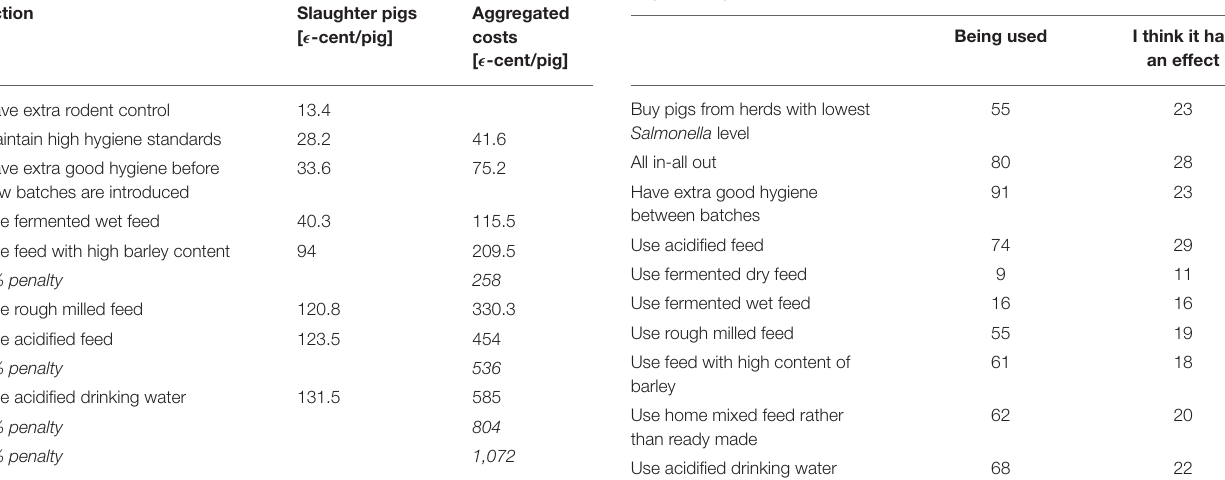
TABLE 6 | Share of farmers who use/have used the presented Salmonella reducing action and the share of farmers who think it has an effect (in percent of